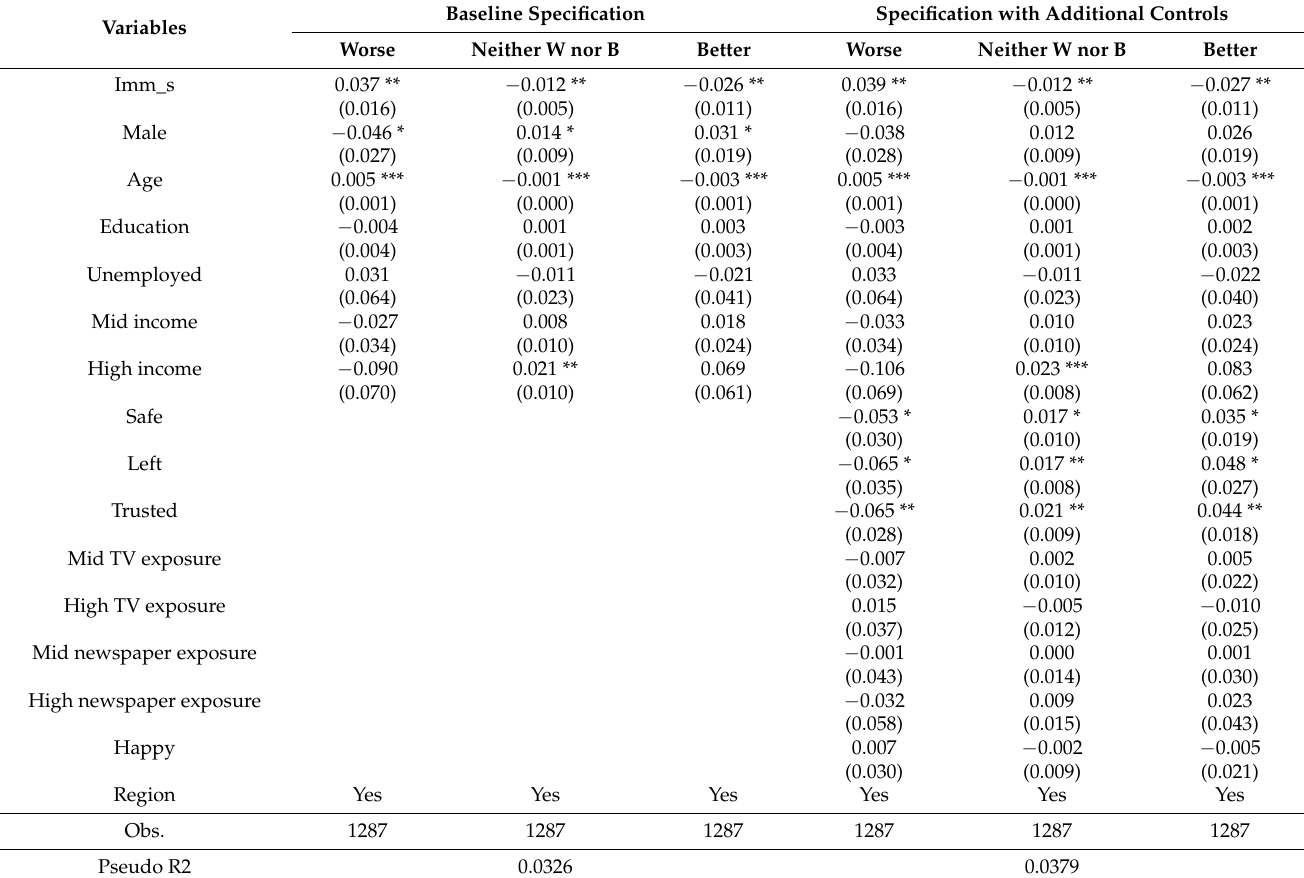
Table 6. Is Turkey made a worse or a better place to live by people coming to live here from other